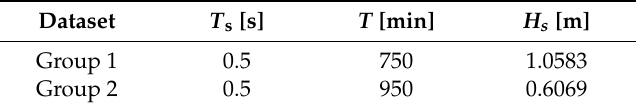
Table 2. Summary of observation